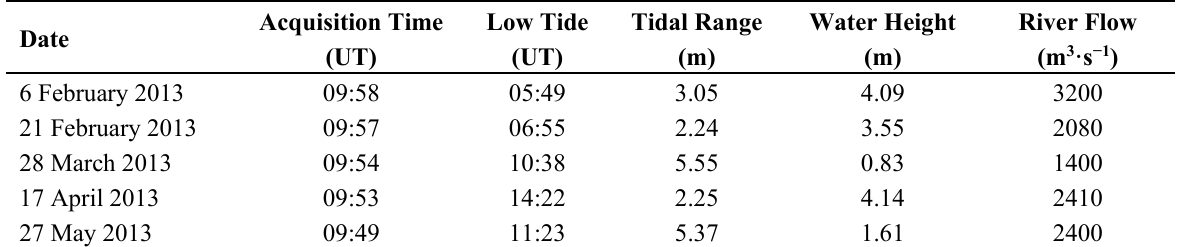
Table 3. List of selected SPOT4 (Take5) data for the Loire estuary. Water height and tidal range provided by the SHOM for the main harbour in the Loire estuary (Saint-Nazaire). River flow data measured at Montjean-sur-Loire, 60 km upstream of Nantes.